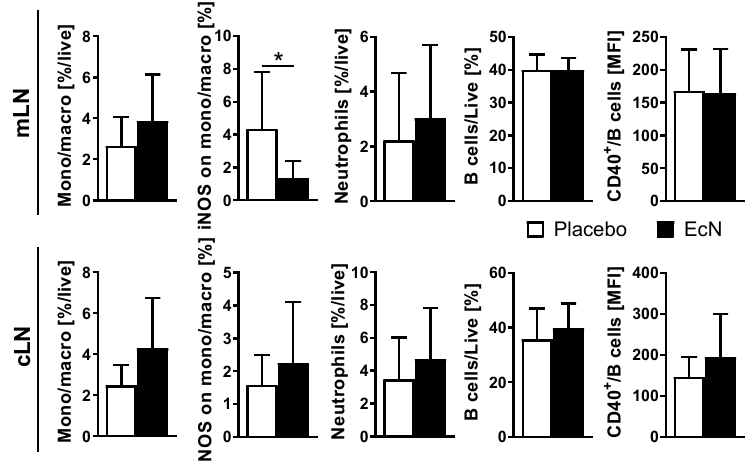
Figure 8. Flow cytometric analysis of myeloid cells in gut-draining and eye-draining lymph nodes (mLN and cLN, respectively) at day 28 post-induction. Live EcN treatment decreased the propor- tion of iNOS+ monocytes/macrophages in mLN but not in cLN. Data are pooled from 2 independ- ent experiments ( n = 11 per group in total) and differences were quantified by unpaired Mann Whitney test; * p < 0.05. The monocytes/macrophages are defined as live cells CD45+CD11c-B220- CD3-CD49b-Ly-6G-SSClo, neutrophils are defined as live cells CD45+CD11c-B220-CD3-CD49b-Ly- 6G+ and B cells are described as live cells CD45+CD11c-B220+, as described earlier [47].